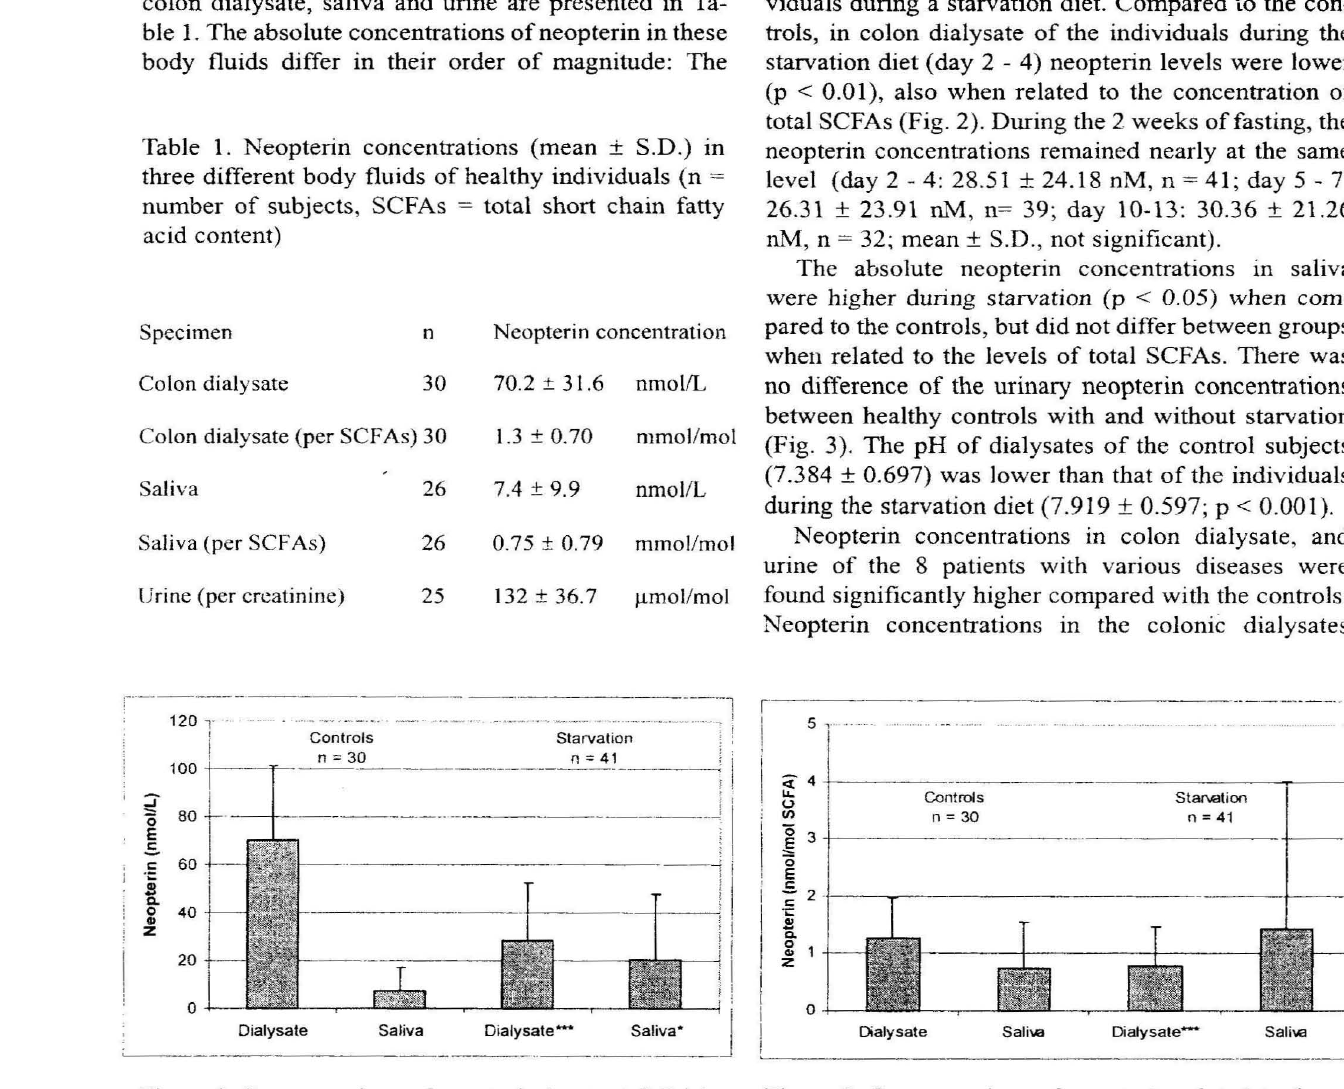
Table 1. Neopterin concentrations (mean ± S.D.) in three different body fluids of healthy individuals (n = number of subjects, SCFAs = total short chain fatty